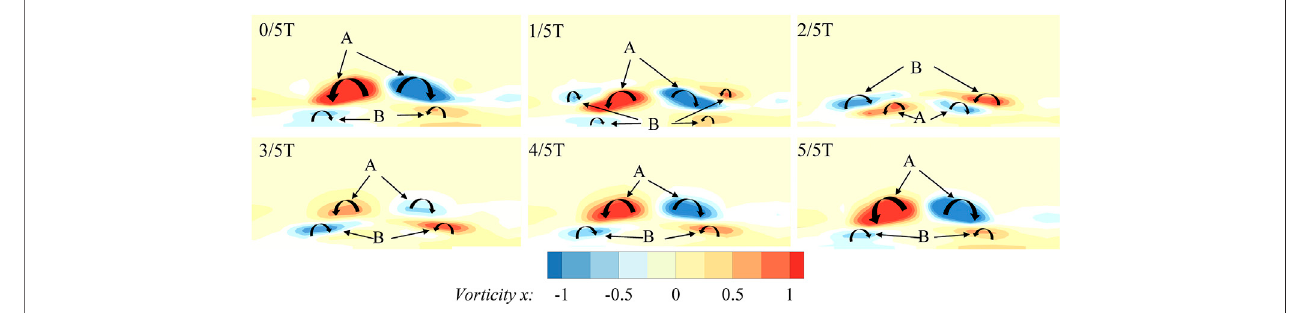
FIGURE 15 | Streamwise vorticity contours downstream the dimple trailing edge in one cycle of vortex